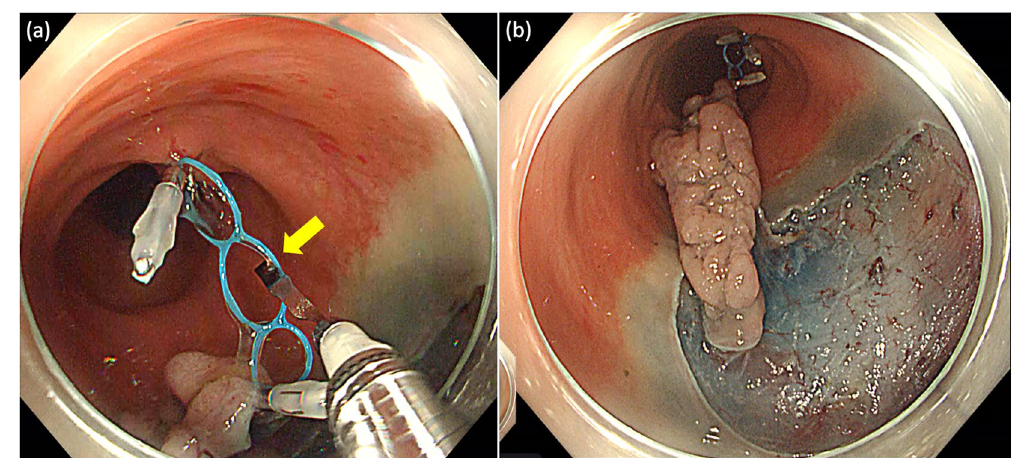
Figure 2. Additional traction. ( a ) When the traction effect was inadequate, additional traction was applied using the hole in the middle (yellow arrow). ( b ) After additional